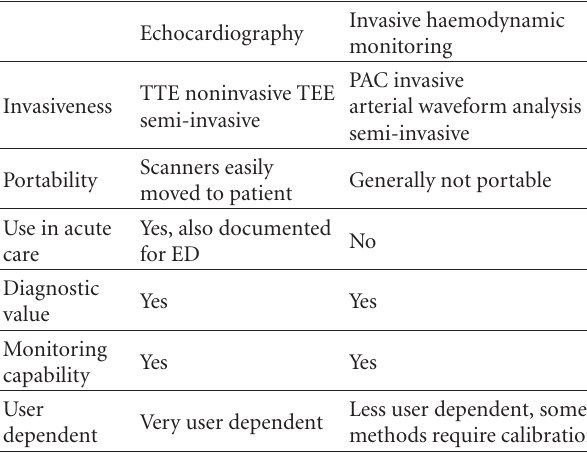
Table 2: Indications for echocardiography in acute care settings, evaluated using appropriate use scores